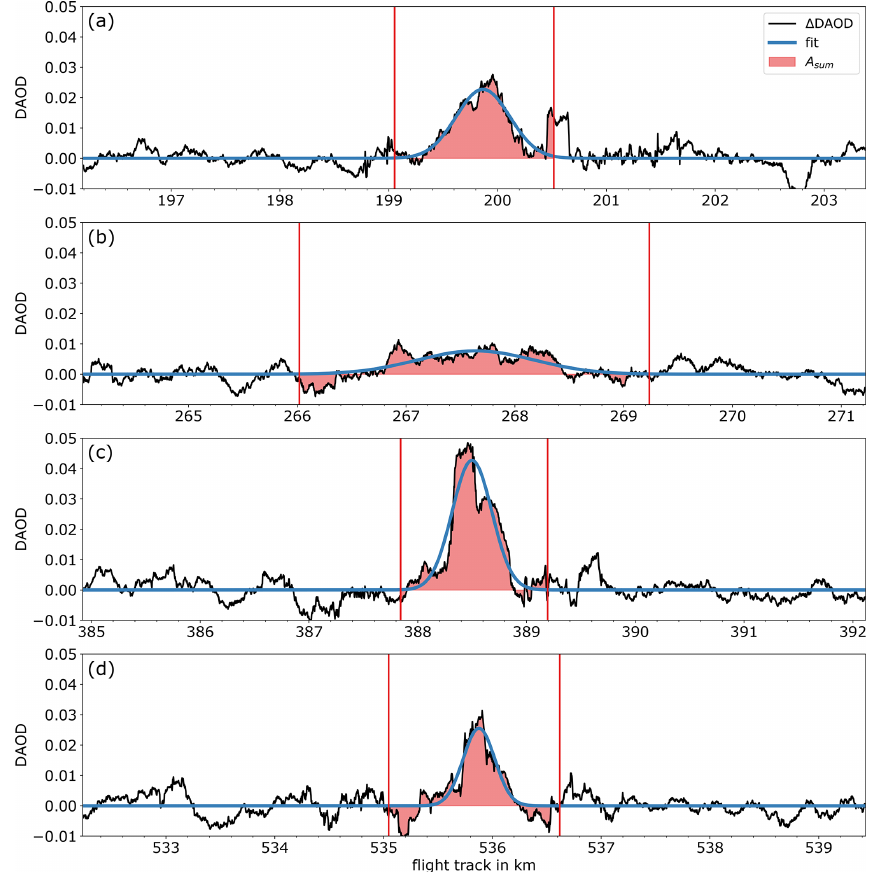
Figure A1. Figures of individual HALO crossings on 23 May 2018. Individual transects listed in Table 1. The black line shows a 0.2km (64 data points) running mean, as first presented in Fig. 3. Vertical red lines mark the smallest data extract used for the Riemann sum, as described in Sect. 3.